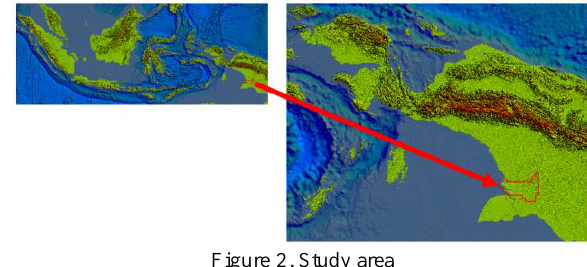
Figure 2. Study area